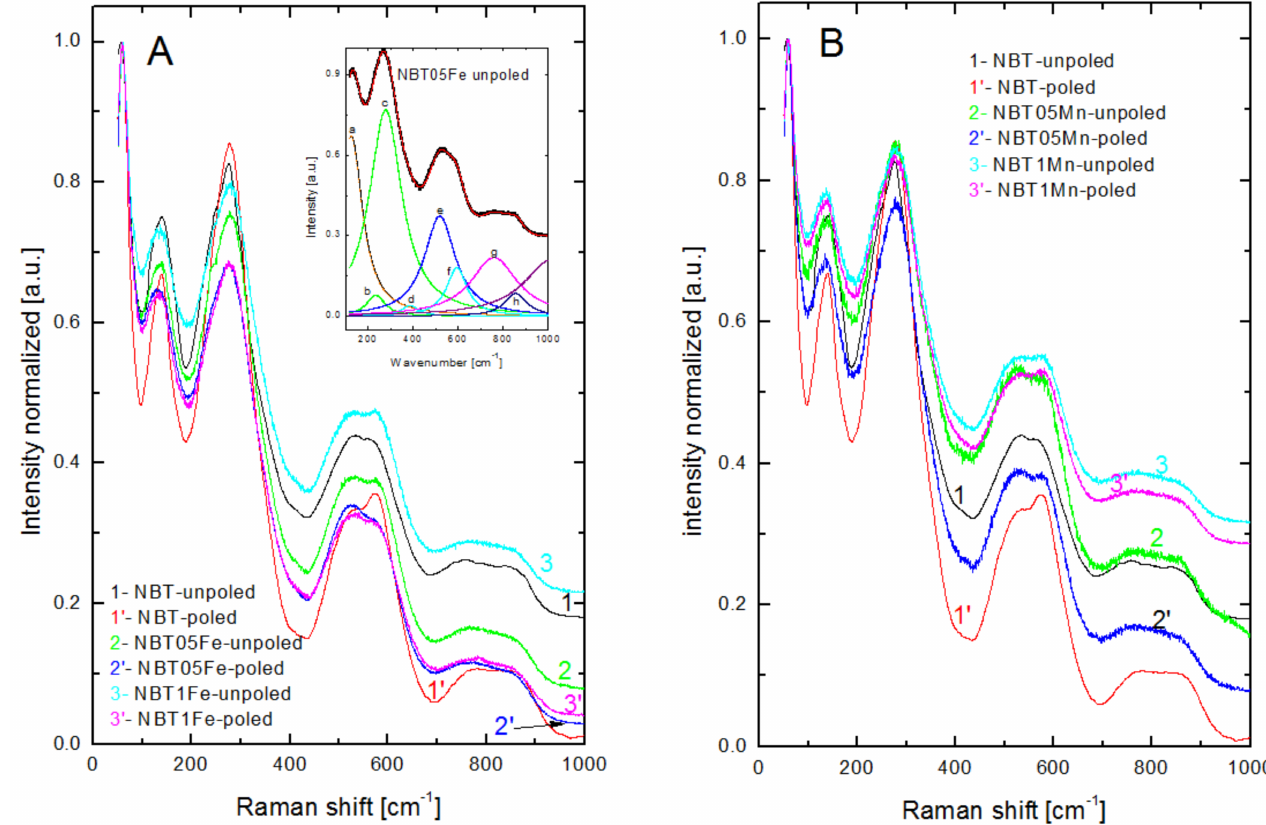
Figure 7. Room-temperature Raman spectra of the investigated samples in unpoled and poled states. Inset shows the spectral deconvolution of the room-temperature Raman spectrum of NBT05Fe. The a, b, c, d, e, f, g and h are mode names. ( A ) Fe-doped NBT, ( B ) Mn-doped